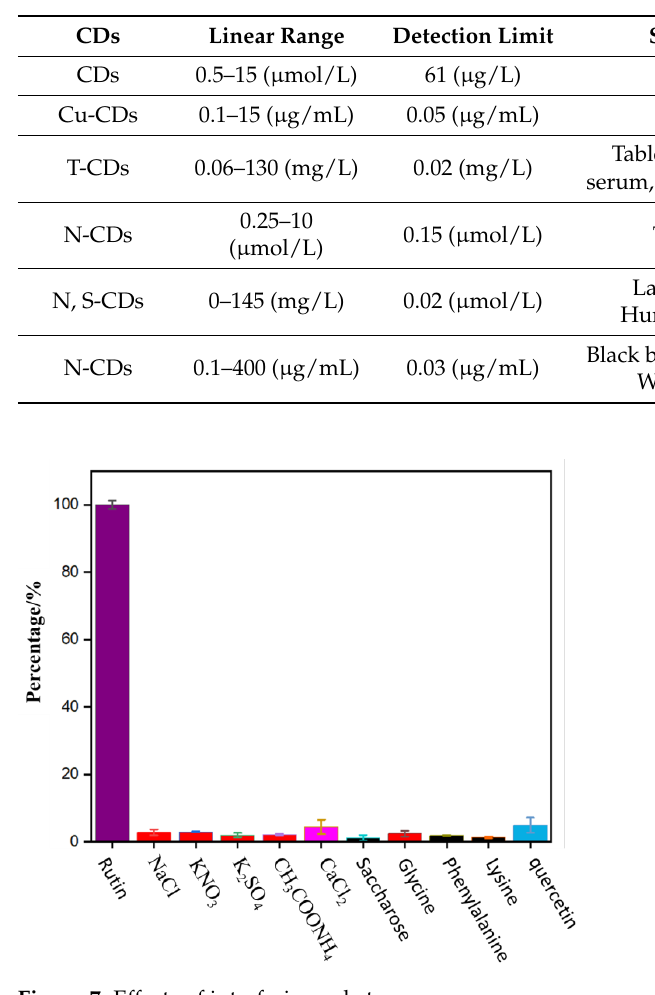
Figure 7. Effects of interfering substances.